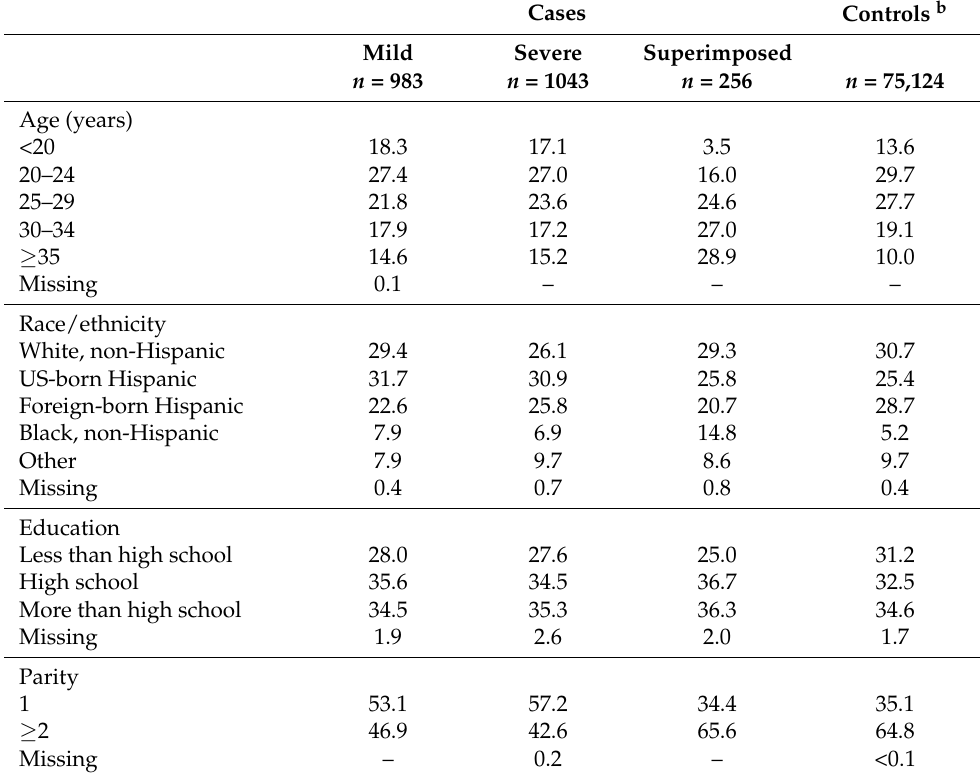
Table 1. Descriptive characteristics (%) a of 2282 women with preeclampsia by phenotype and 75,124 controls in California from 2000 to